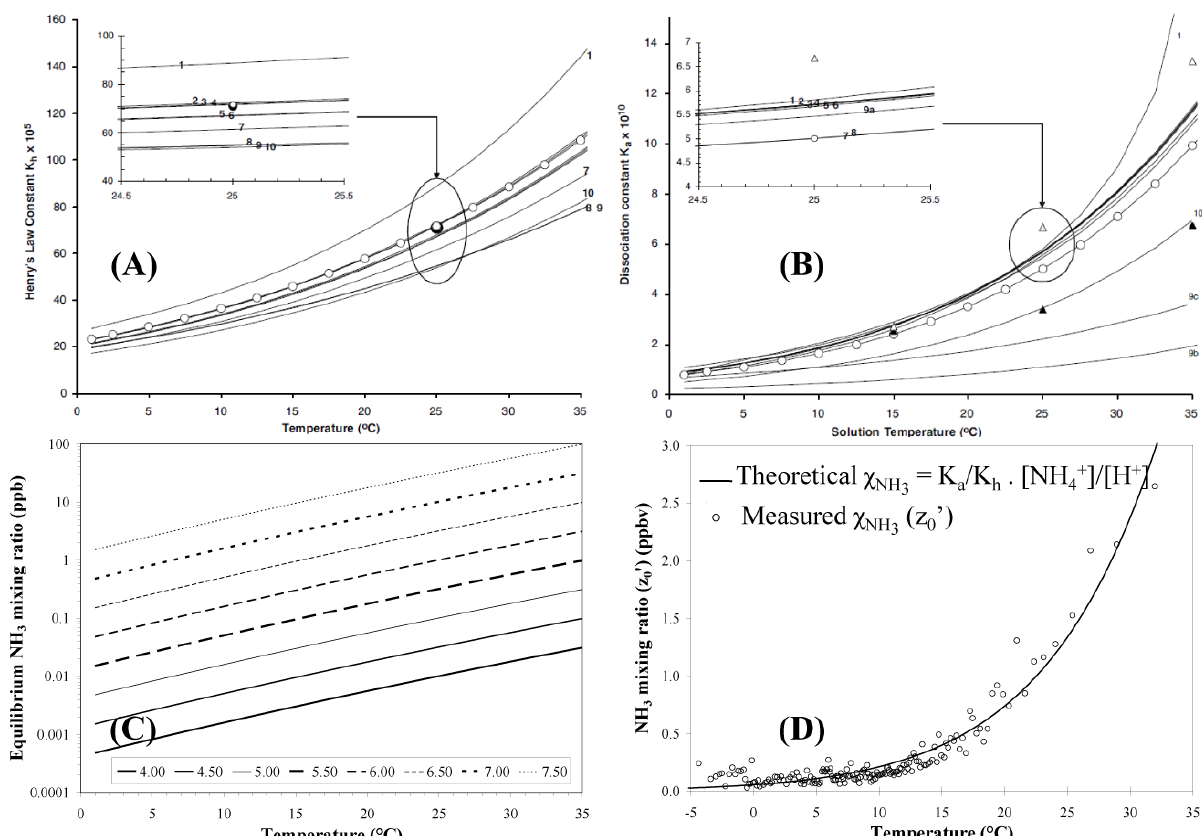
Fig. 1. Thermodynamic controls of the air/solution NH 3 /NH + partitioning. (A) and (B) : compilation by Montes et al. (2009) of published 4 values, parameterizations and temperature dependencies of Henry’s law coefficients ( K h ) and dissociation constants ( K a ) ; the curve numbers refer to specific experiments cited in Montes et al. (2009), for solutions ranging from pure water to slurries and high activity solutions; (C) : theoretical equilibrium air NH 3 concentration of a 100µM NH + solution as a function of temperature and showing the effect of pH in 4 the range 4 to 7.5, calculated according to Sutton et al. (1994); (D) : fitting of a theoretical thermodynamic curve to micrometeorologically measured surface NH 3 ( z 0 ‘) concentrations over Scottish peatland, resulting in a best fit for the [NH + ]/[H + ] ratio ( 0 ) of 132 for the 4 moorland ecosystem (Flechard and Fowler,